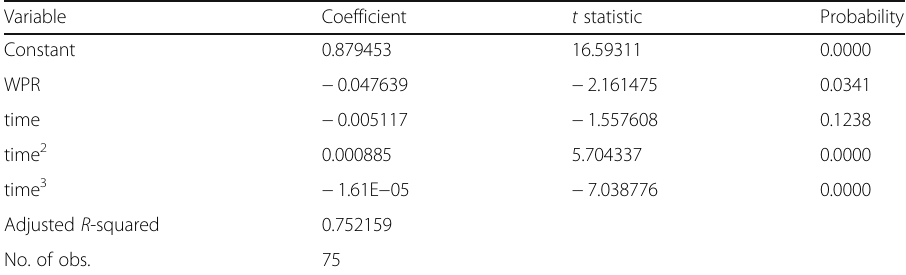
Table 17 How TFP is affected by WPR —